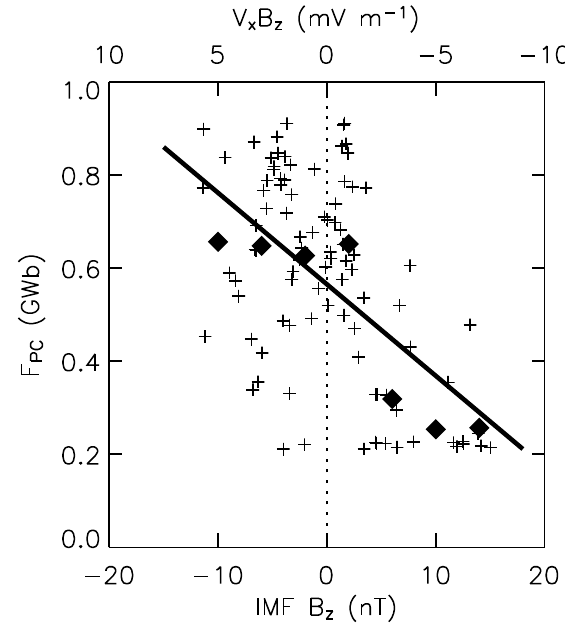
= 8 PC and 8 0 = 2 8 PC . PC PC Fig. 4. Polar cap flux as a function of IMF B z . The solid curve shows a least-squares fit, the diamonds show average values in 4nT- wide bins of B z